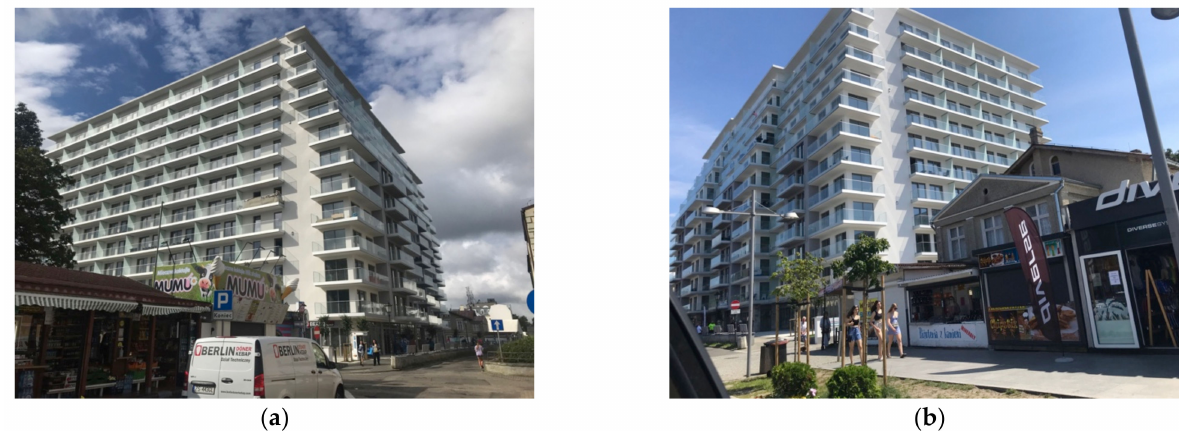
Figure 9. Mi˛edzyzdroje, Balticus Apartments—an example of monstrous buildings in the central part of the resort ( a , b ). Source: Author’s photo ( a , b